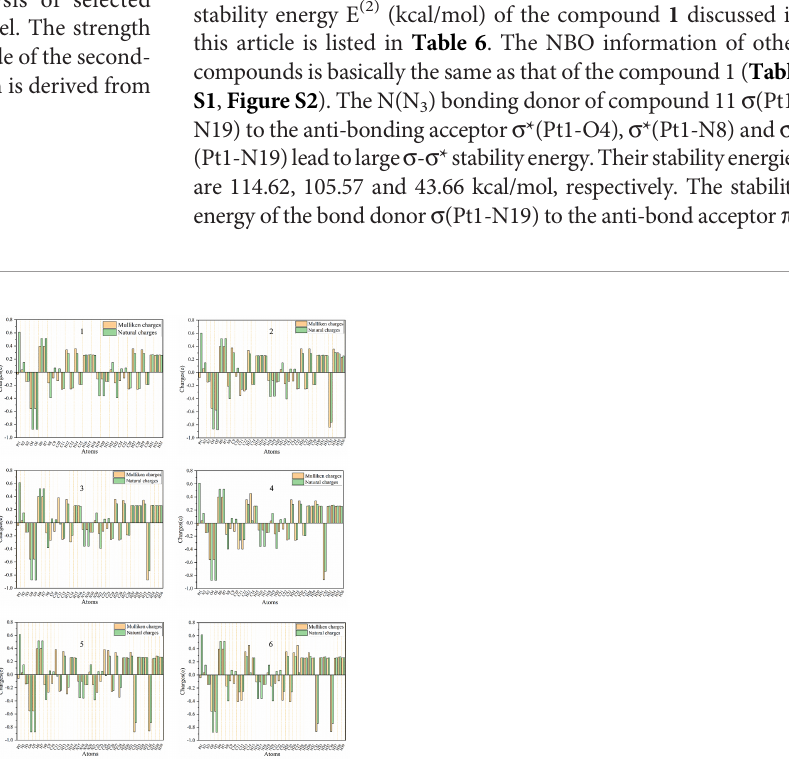
Frontiers in Oncology |